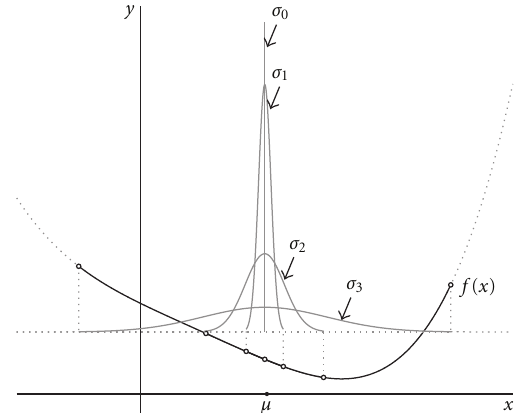
Figure 1: E ff ective vicinities of the cross-section mean, which contribute to the integral, for the standard deviations σ 3 > σ 2 > σ 1 > σ 0 = 0. Dots on the curve y = f ( x ) represent the boundaries of the corresponding e ff ective intervals on which integrand is essentially not